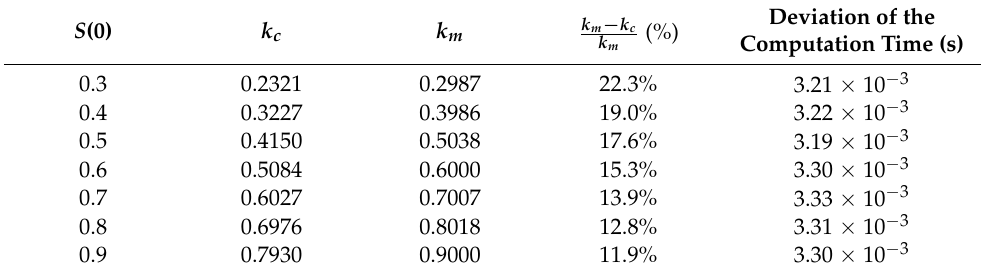
Table 3. The effective thermal conductivity in circle pores compared with the effective medium theory method.